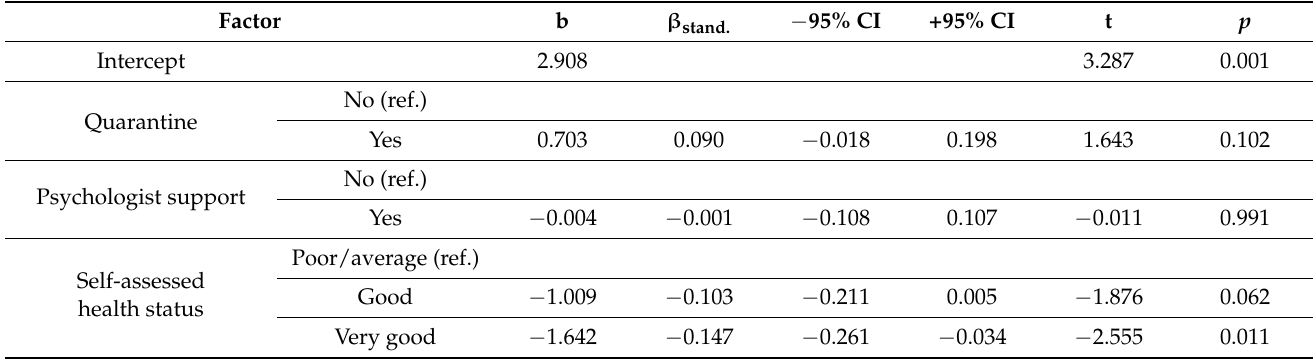
Table 4. Effect of self-rated health, quarantine, psychological support, presence of chronic diseases and the Impact of Event Scale—Revised (IES-R) dimensions on the level of depression according to the PHQ-9 (model